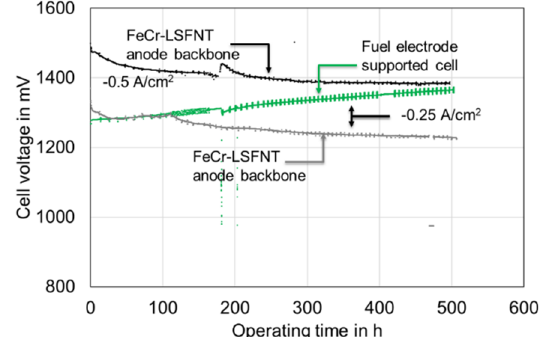
Figure 5. Cell voltage vs. operating time under constant electrolysis current of − 0.25 and − 0.5 A/cm 2 at 650 °C in 50% H 2 O/H 2 fuel vs. air using a ceramic fuel electrode supported cell (green curve) and the metal supported cells (grey and black curves).